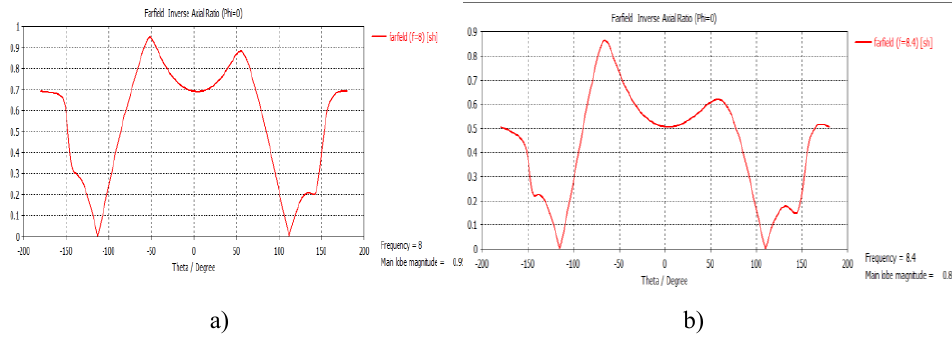
Fig. 6. Dependencies of the ellipticity coefficient on angular coordinates.